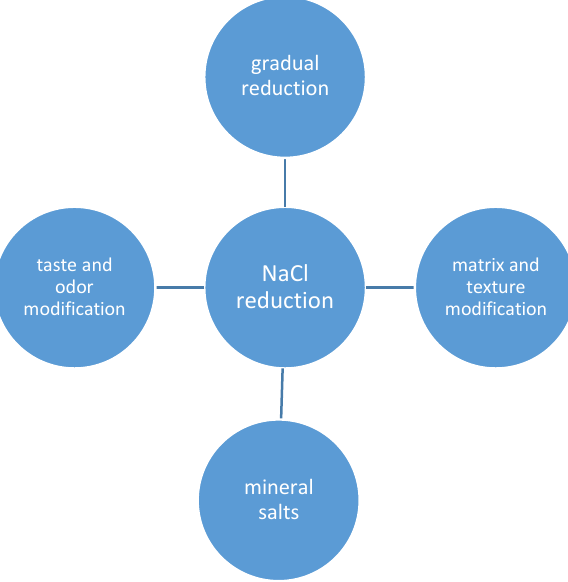
Figure 1. Overview of options for salt (NaCl) reduction in foods covered in this review.